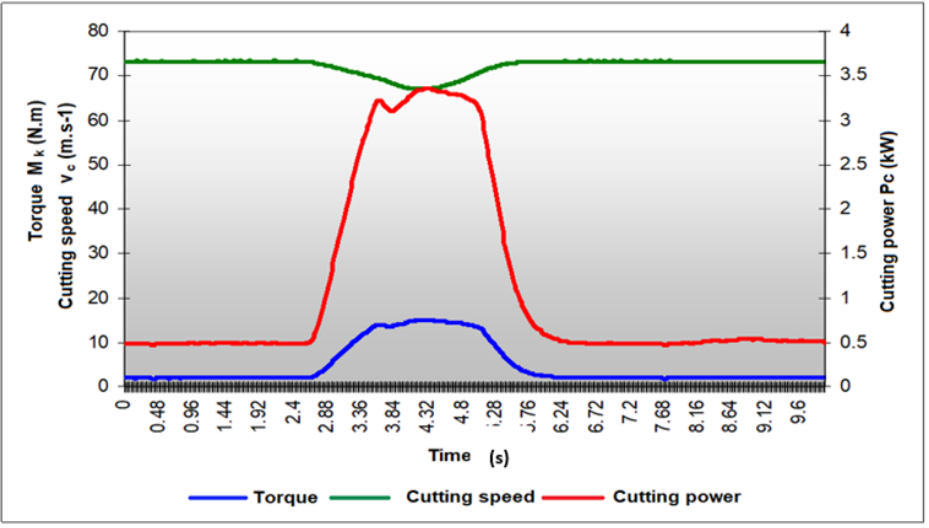
Figure 5. Course of the measured Mk during a transverse cut with a circular